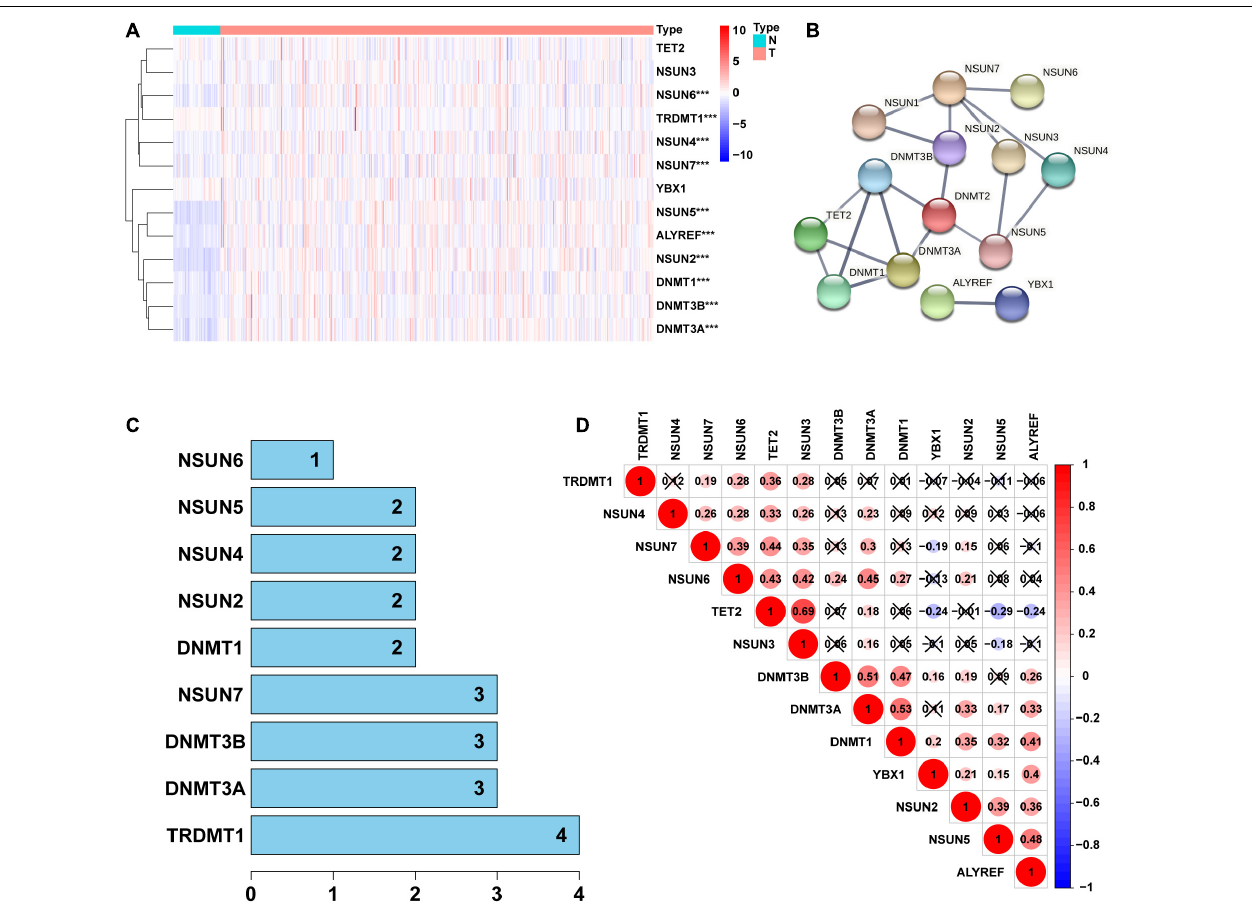
FIGURE 1 | Identification of differentially expressed genes between 5-Methylcytosine (m5C) regulators in lung adenocarcinoma (LUAD) and normal groups. (A) Heatmap visually showing the differences in the expression of m5C regulators between the 2 groups. (B,C) Protein–protein interaction (PPI) network showing the interaction between differentially expressed genes among m5C regulators. (D) Pearson correlation analysis of the m5C regulators. N, normal samples; T, tumor samples; *** p < 0.001.